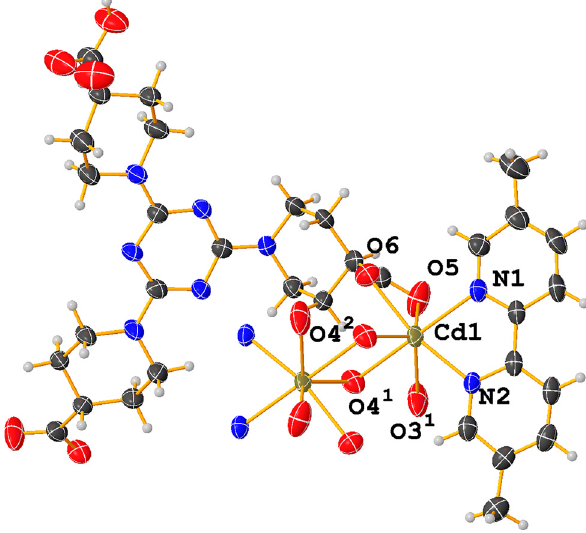
Table 1 contains crystallographic data and Table 2 contains the list of the atoms including atomic coordinates and displacement parameters.